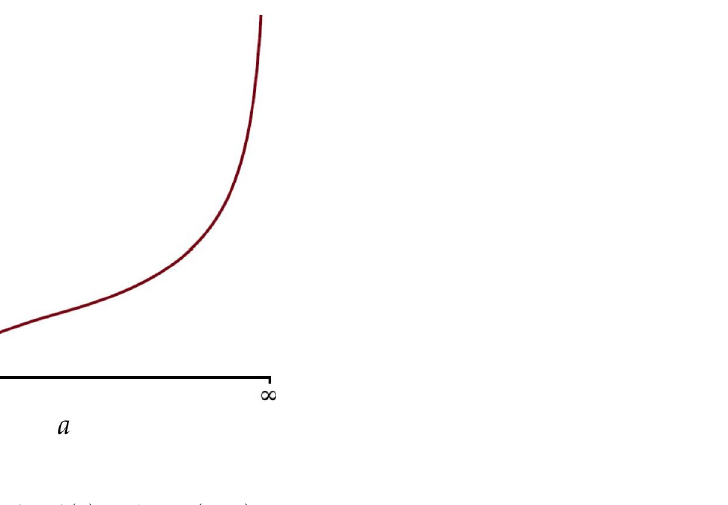
Figure 1. The curve k = k ( a ) with a